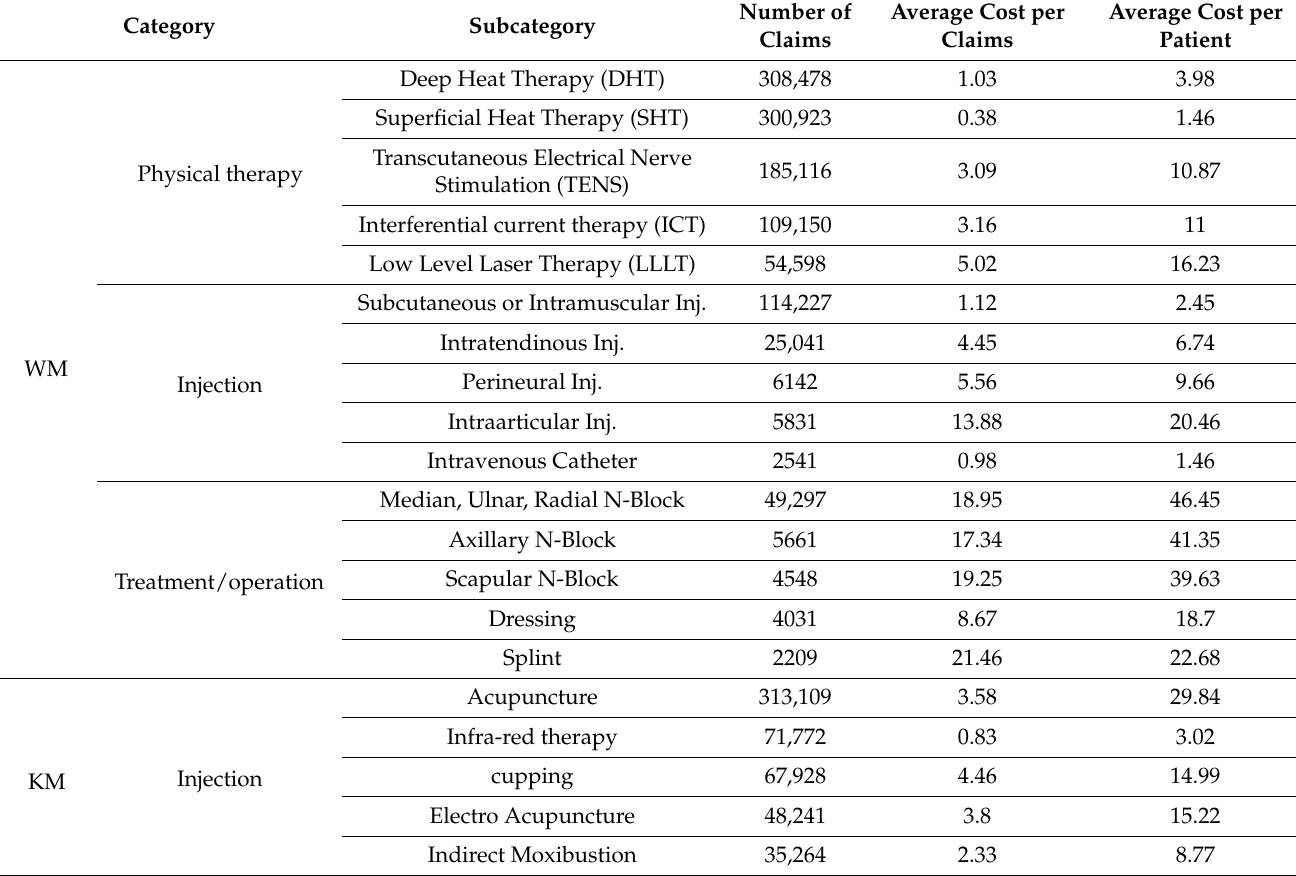
Table 4. The five most frequently performed interventions in WM/KM over nine